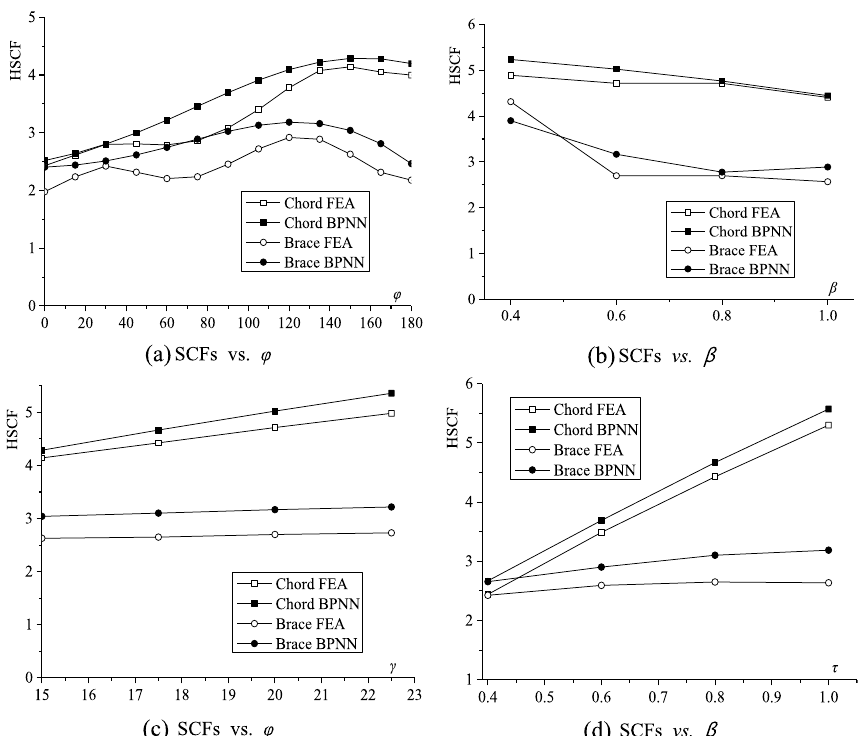
Fig. 15 SCFs of CFST Y-joints with different input